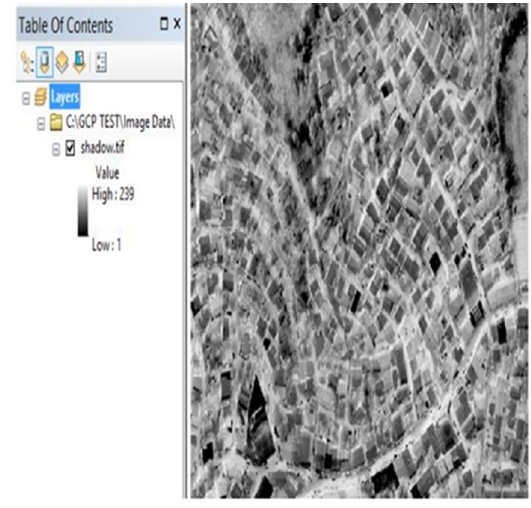
Figure 7: Shadow index